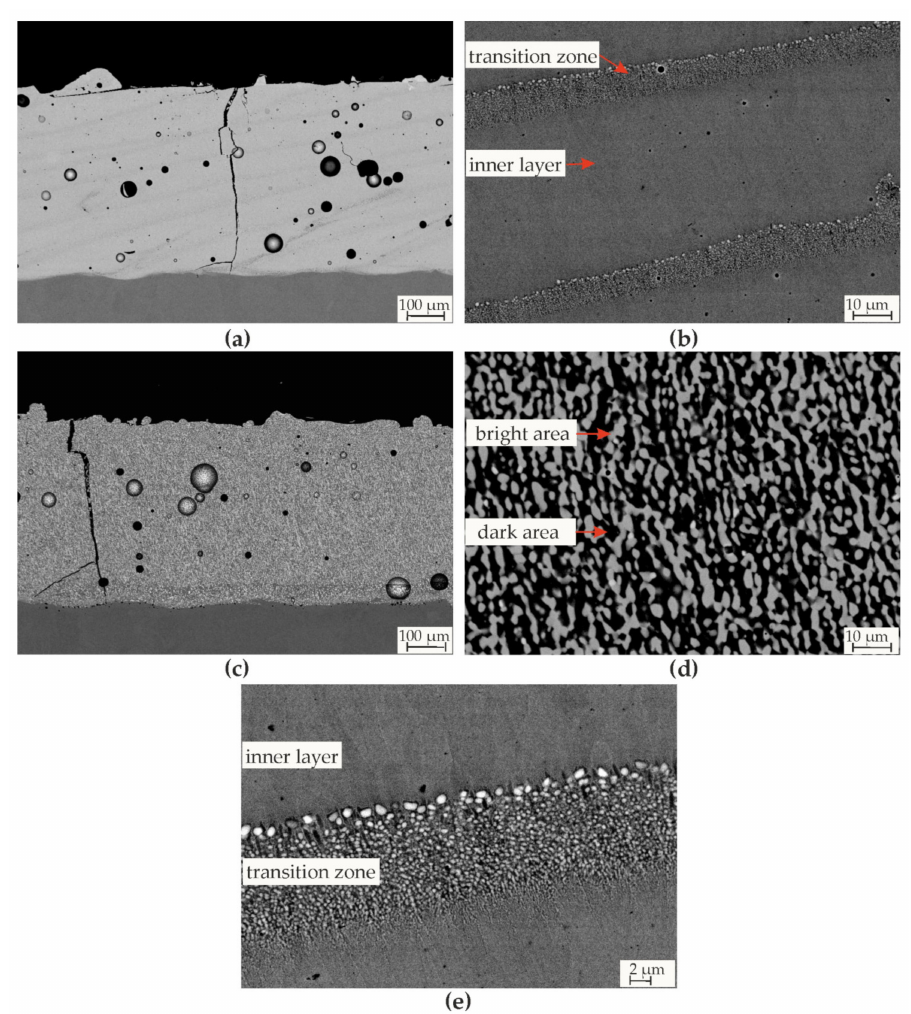
Figure 2. Microstructures (SEM, BSD) of the Al0.3CoCrFeNiNb0.5 LMD coating: untreated ( a ) overview and ( b ), ( e ) detail; and heat-treated ( c ) overview and ( d ) detail. A directional solidification was observed in the untreated LMD coating. Due to the heat treatment, the microstructure coarsened and the distortion orientation of the lamellae was less